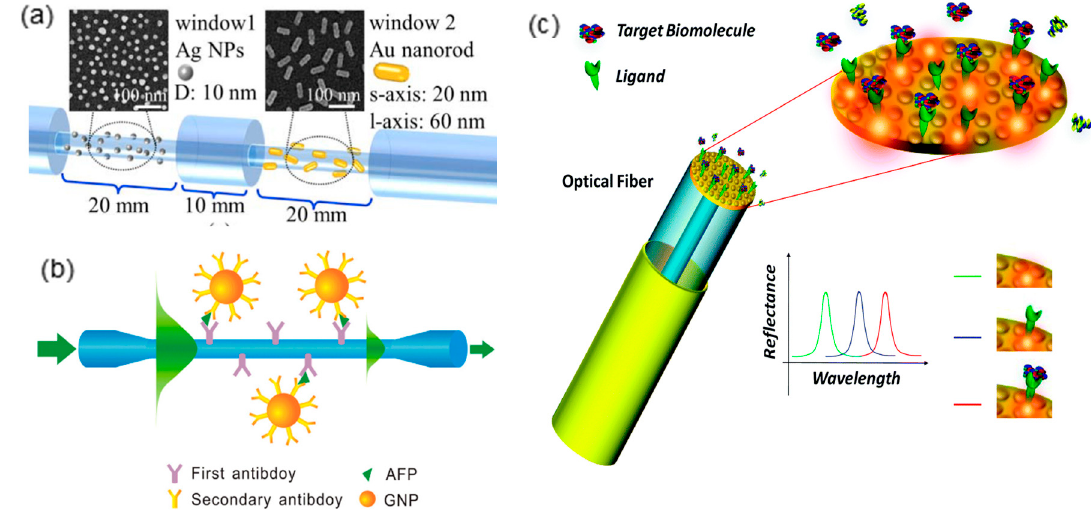
Figure 11. The LSPR devices based on various optical fiber structures such as ( a ) cascaded unclad fiber (Figure adapted with permission from reference [97]); ( b ) microfiber (Figure adapted with permission from reference [98]); ( c ) optical fiber endface (Figure adapted with permission from reference [99]).